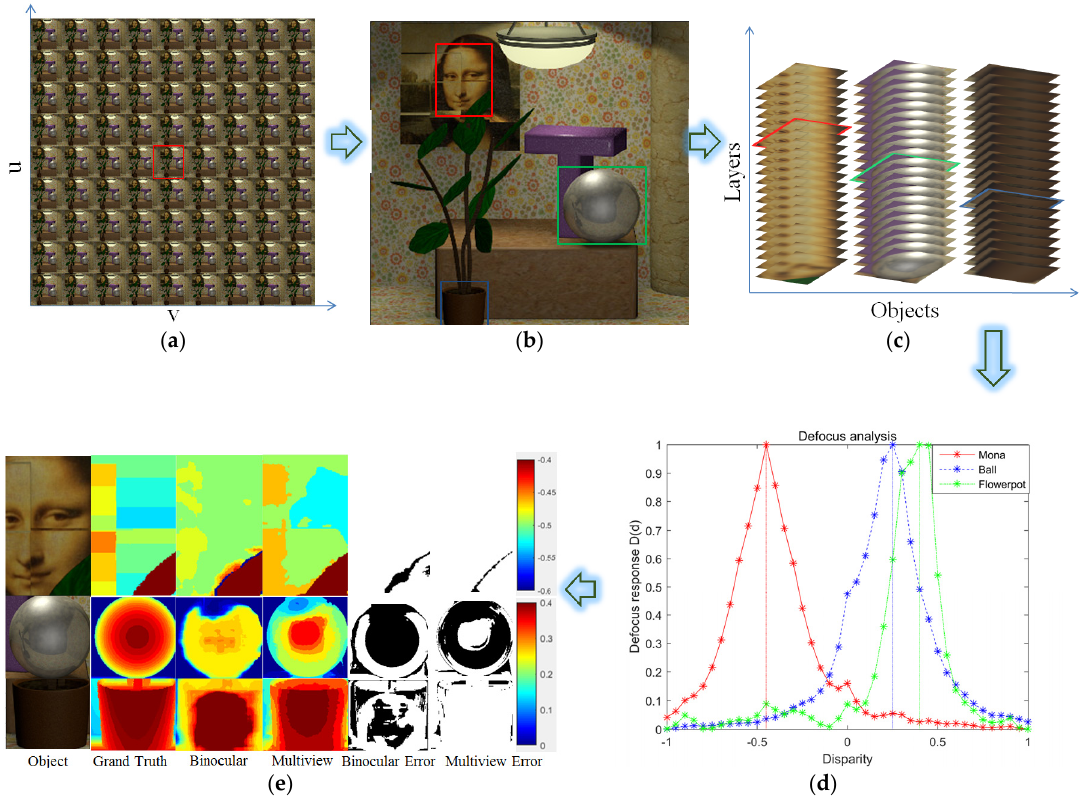
Figure 6. Result of Mona synthetic 4D light. ( a ) The input 4D light field. ( b ) Identified objects in all focus image. ( c ) Focal stacks of object regions. ( d ) Depth estimation by defocus analysis of the down sampled focal stacks. ( e ) Depth estimation of objects by stereo matching. Table 1. A summary of the stereo matching results of the identified objects.